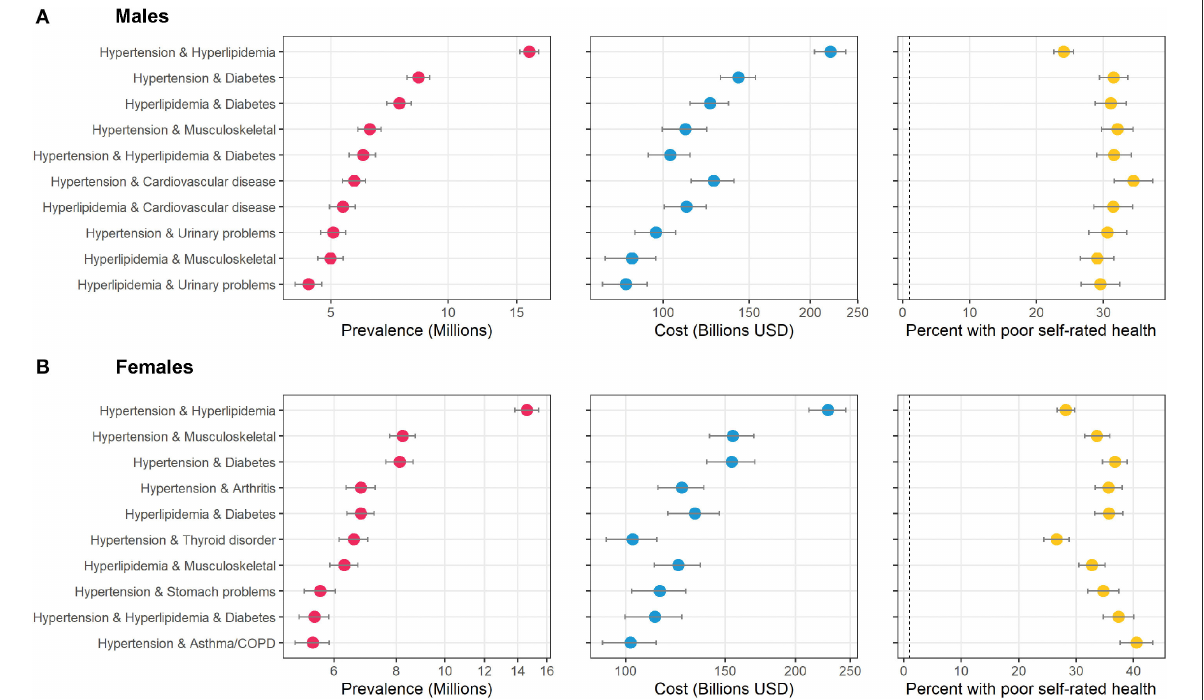
FIGURE3 Top ten most prevalent specific combinations of multimorbidity by sex and associated cost and perceived poor health. The figure shows the top ten combinations of conditions as ranked by prevalence by sex among adults in the United States. (A) shows data on males, and (B) shows data on females. Data source: the 2016–2019 Medical Expenditure Panel Survey (MEPS). Weighted estimates and 95% confidence intervals were calculated by applying population weights using Taylor-series methods (i.e., complex survey methods) to account for the complex sampling design of the MEPS. Weighted estimates have been annualized by taking the average over the 4-year study period. X-axes for prevalence and cost are on the logarithmic scale. Results are sorted by prevalence. Cost is measured as total annual medical expenditures in 2019 US Dollars, and perceived health is an answer of “fair” or “poor” on a 5-point question asking respondents to rank their overall health.